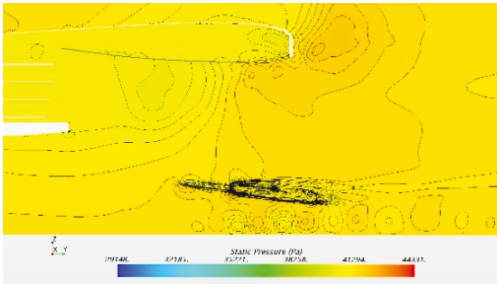
Figure 19: Flow fi eld pressure contour at 1.0s.